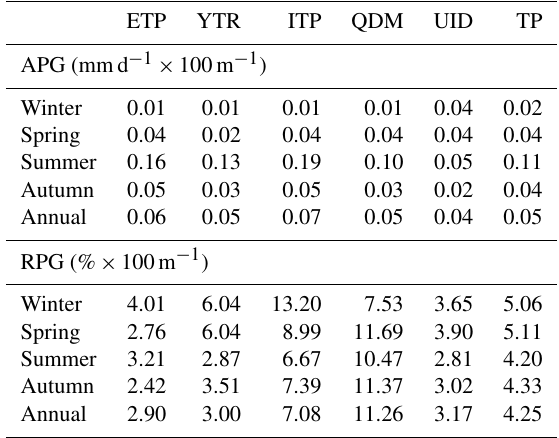
Table 2. The APG and RPG averaged across the sub-basins within the five sub-regions and the whole TP with respect to different sea- sons. ETP: eastern TP; YTR: Yarlung Tsangpo River basin; ITP: inner TP; QDM: Qaidam basin; UID: upper